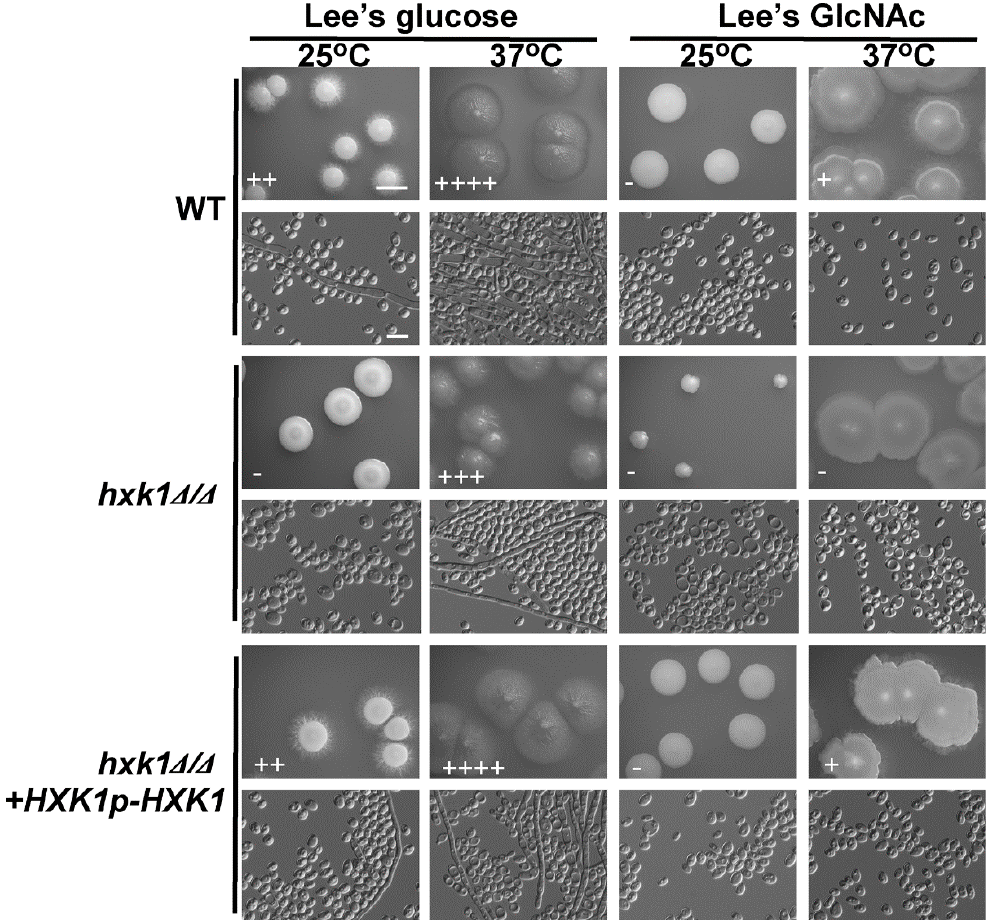
Figure 4. HXK1 deletion markedly reduces C. tropicalis filamentous growth. Cells of WT, hxk1 Δ / Δ mutant, and hxk1 Δ / Δ + HXK1p - HXK1 reconstituted strain were plated on Lee’s agar plates containing glucose or GlcNAc, and after 6 days at 25 °C or 37 °C, representative colony and cellular morphology was assessed. Five individual transformants for each gene were used for filamentous growth assays. The degree of hyphal growth is represented by “+” signs, with the percentages of filamentous cells being indicated as follows: +, 0.1%–5%; ++, 5%–20%; +++, 20%–40%; ++++, 40%–60%. If no hyphal growth was evident, “-” was instead used to indicate cells ( < 0.1%). Scale bars for colonies and cells were 2 mm and 10 μ m, respectively.